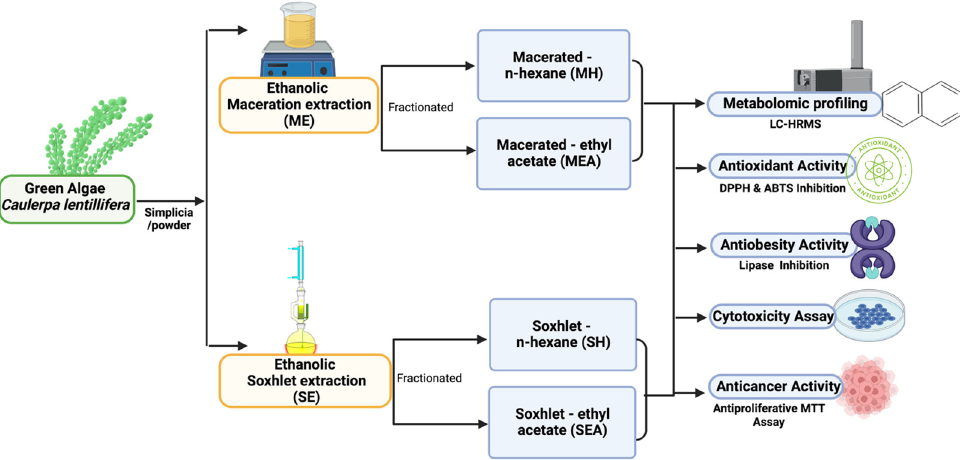
Figure 3. Methodical schematic of Caulerpa lentillifera study. ME : Maceration — Ethanol; MEA : Maceration — Ethyl Acetate; MH : Maceration — n ‐ Hexane; SE : Soxhletation — Ethanol; SEA : Soxhletation — Ethyl Acetate; SH : Soxhletation — n ‐ Hexane.